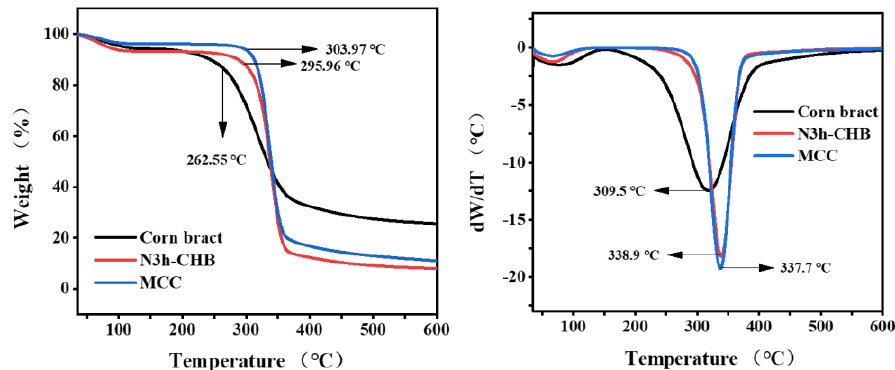
Figure 8. TG/DTG curves of corn bract, N3h-CHB cellulose and MCC.